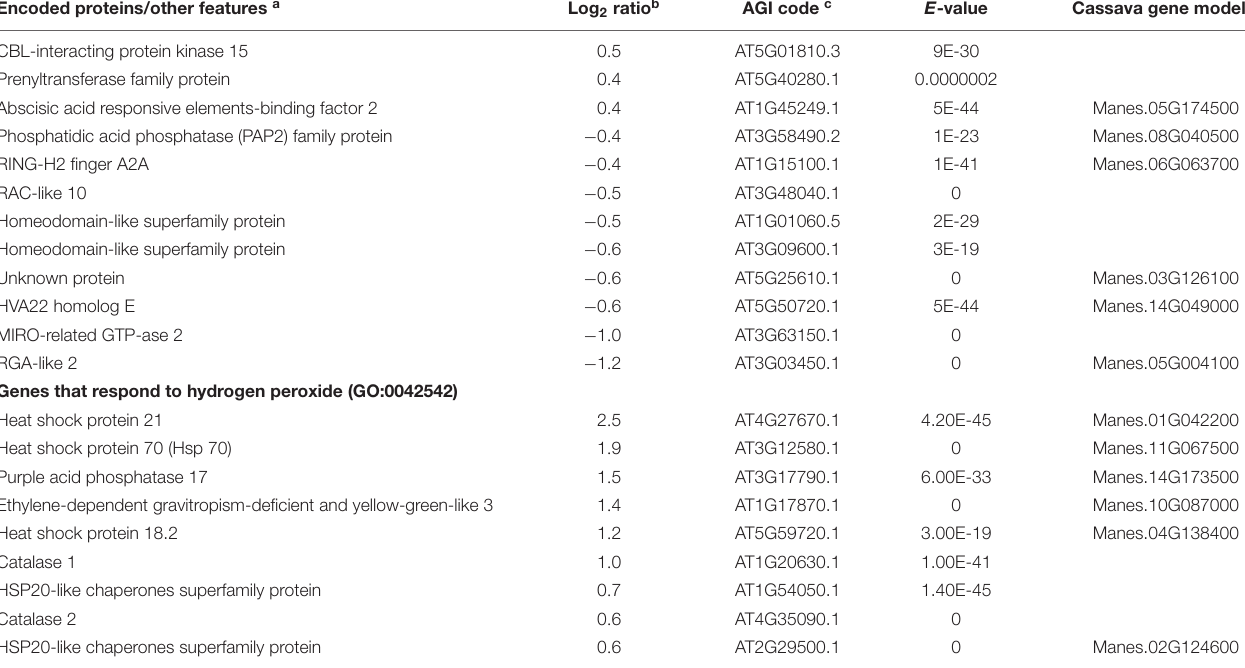
Frontiers in Plant Science |